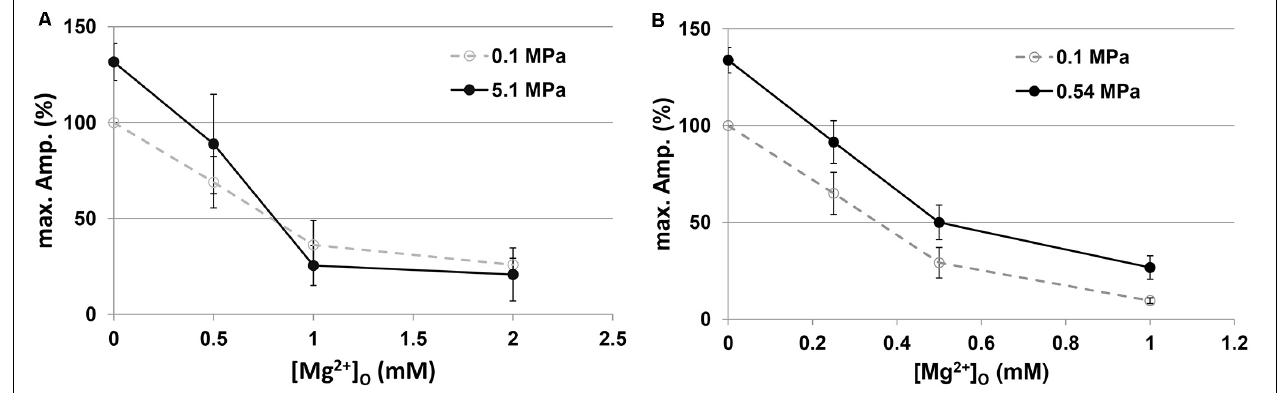
FIGURE 2 | Current amplitudes of the GluN1-1a + GluN2A subtype at different [Mg 2 + ] o . Currents were normalized (%) to the [Mg 2 + ] o = 0 response at 0.1 MPa. (A) Compression with He ( n = 8). (B) Compression with 100% O 2 ( n = 11).